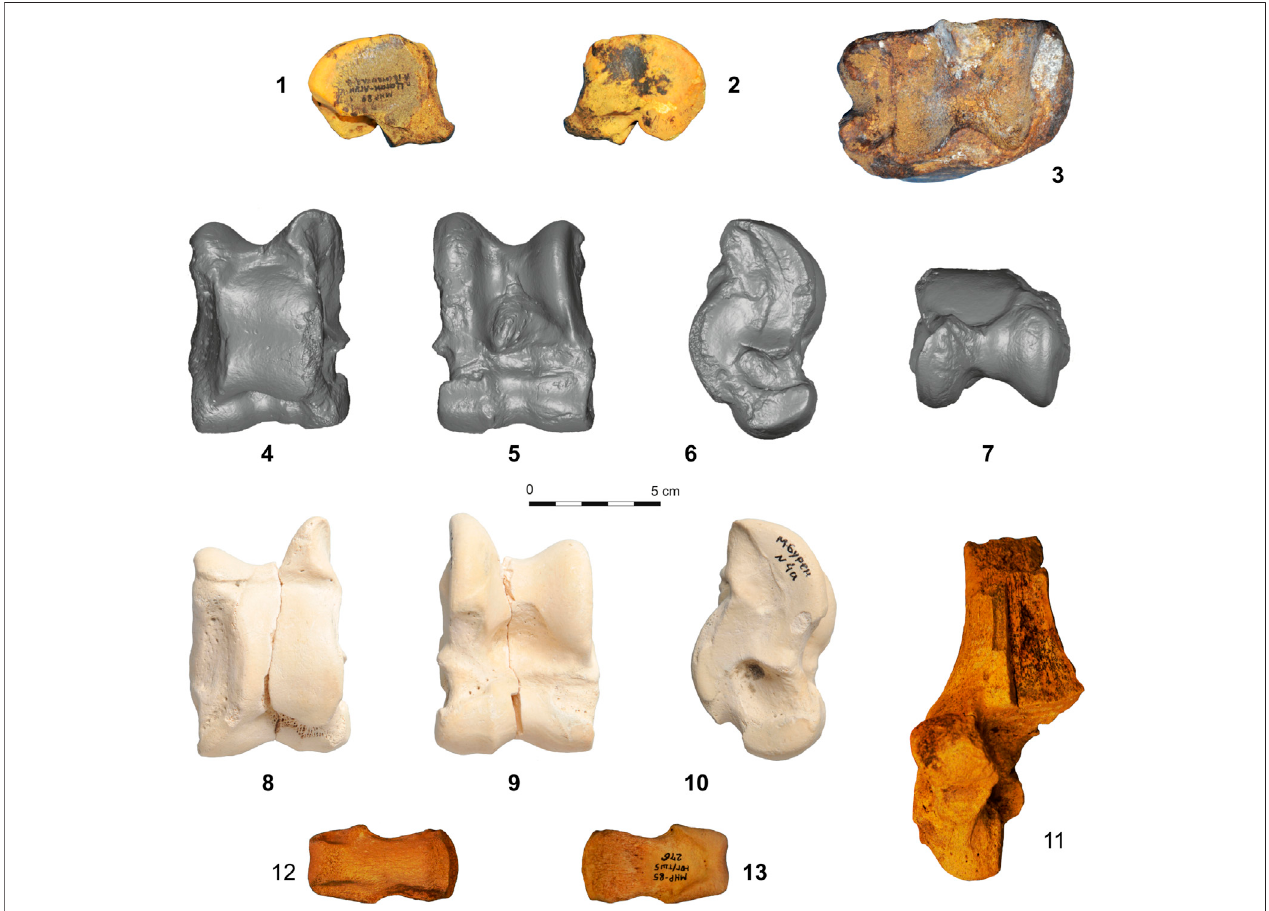
FIGURE3| FossilcamelbonesfromCentralAsia:1,2 – Camelusknoblochi carpalIV+V(distalandproximalview);3 – Camelusknoblochi distaltibiafragment(distal view); 4 – 7 – C. knoblochi astragalus (dorsal, plantar, lateral and proximal views); 8 – 9 – Paracamelus sp. astragalus (dorsal, plantar and lateral views); 11 – fragmentary C. knoblochi calcaneus(viewfromthedorsalside);12 – 13 – C.ferus secondphalanxofthehindleg(Sites:1 – 7,11 – TsagaanAguiCave;8 – 10 – MogenBuren;12 – 13 – Tugrug Shireet).